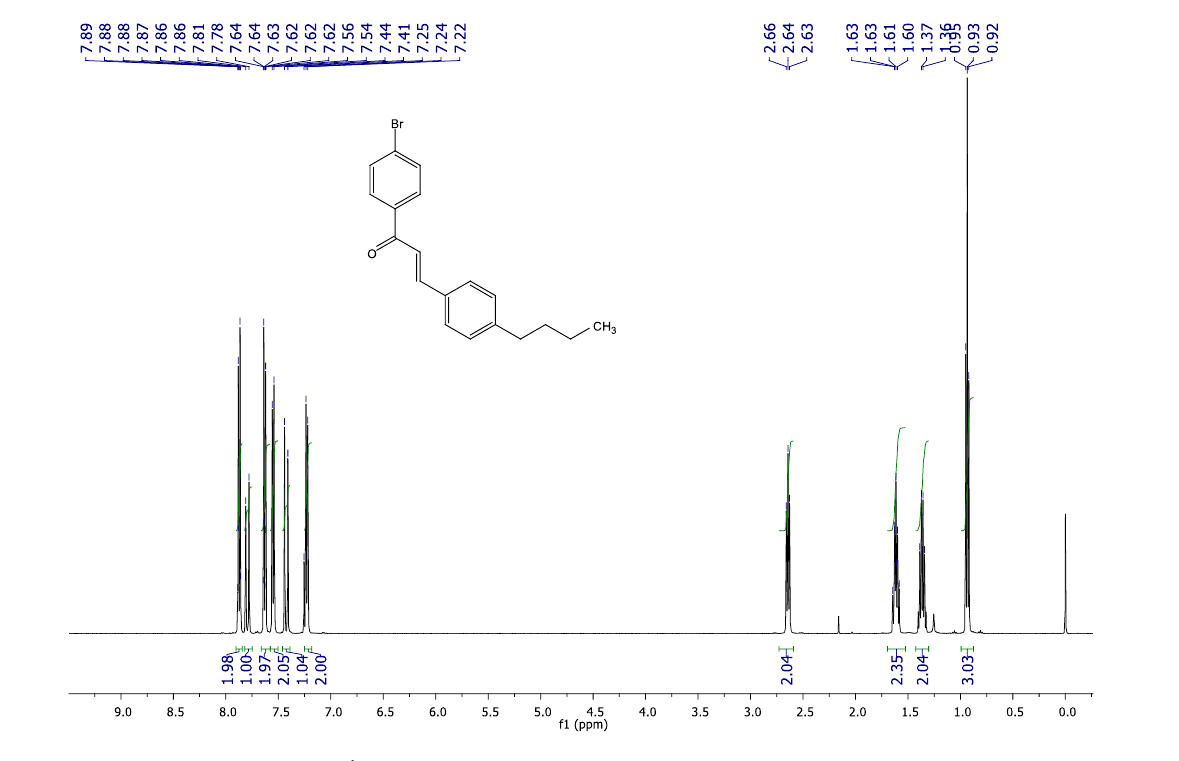
Figure 4. 1 H-NMR spectrum of BBP.